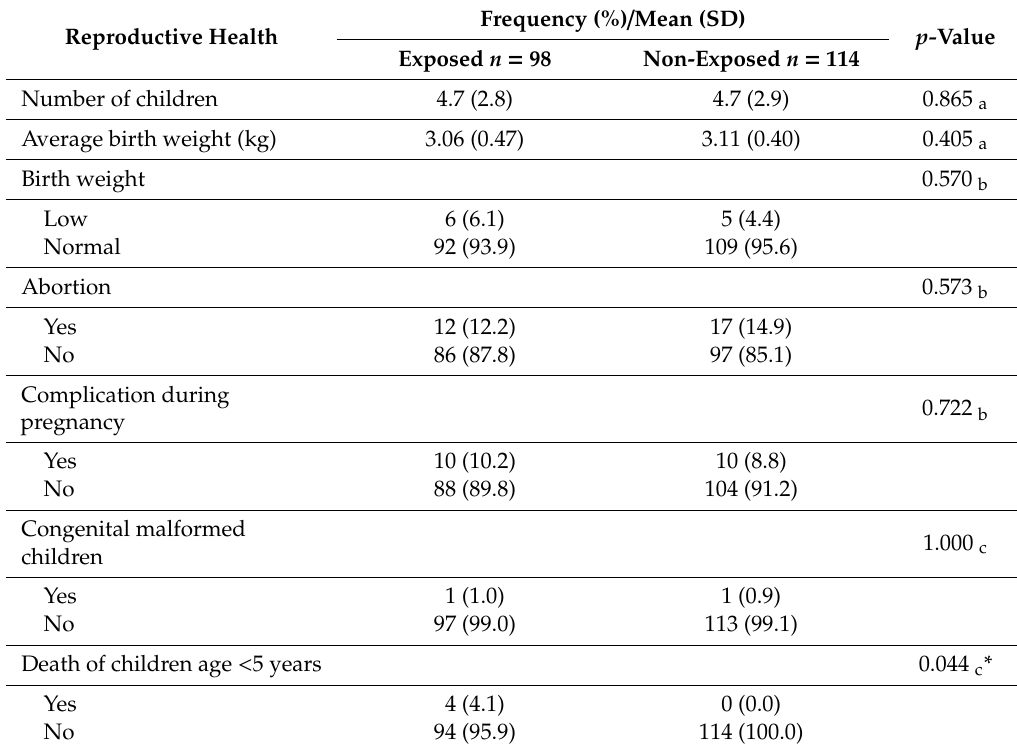
Table 7. Comparison of reproductive health of residents in past 10 years between exposed and unexposed to the